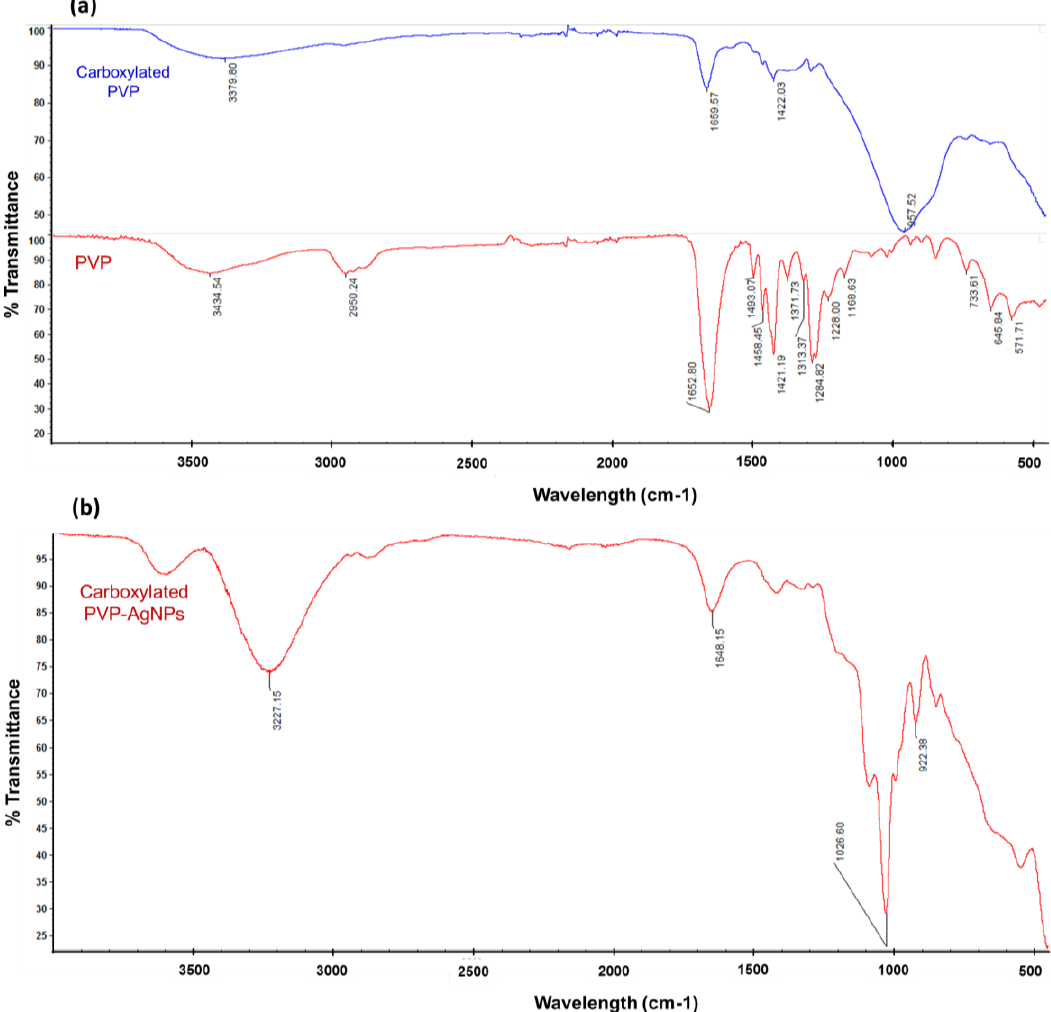
Figure 2. Fourier transform-infrared spectroscopy (FT-IR) spectra of ( a ) PVP and carboxylated PVP; and ( b ) dried carboxylated PVP-coated silver nanoparticles. The FT-IR spectra of carboxylated PVP show a change in the pyrrolidone C=O group peak at ~1659 cm − 1 corresponding to the C=O stretching of the pyrrolidone ring confirming the ring opening; and a broad peak that centers at ~3379 cm − 1 confirming the presence of carbonyl and hydroxyl moieties of the carboxylic acid group. On top: Carboxylated PVP; Bottom: PVP. The FTIR spectra of carboxylated Ag-PVPs show a strong band at ~1648 cm − 1 of the carbonyl group stretching of PVP indicating the PVP capping of silver nanoparticles and a broad peak that centers at ~3227 cm − 1 of the O–H and C–H stretching confirming the presence of carboxylic acid groups.